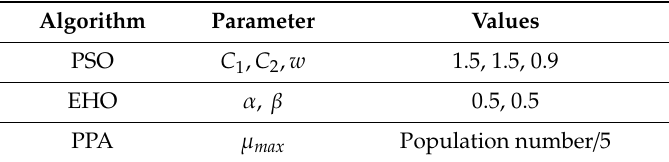
Table 3. Parameters for di ff erent metaheuristic algorithms.